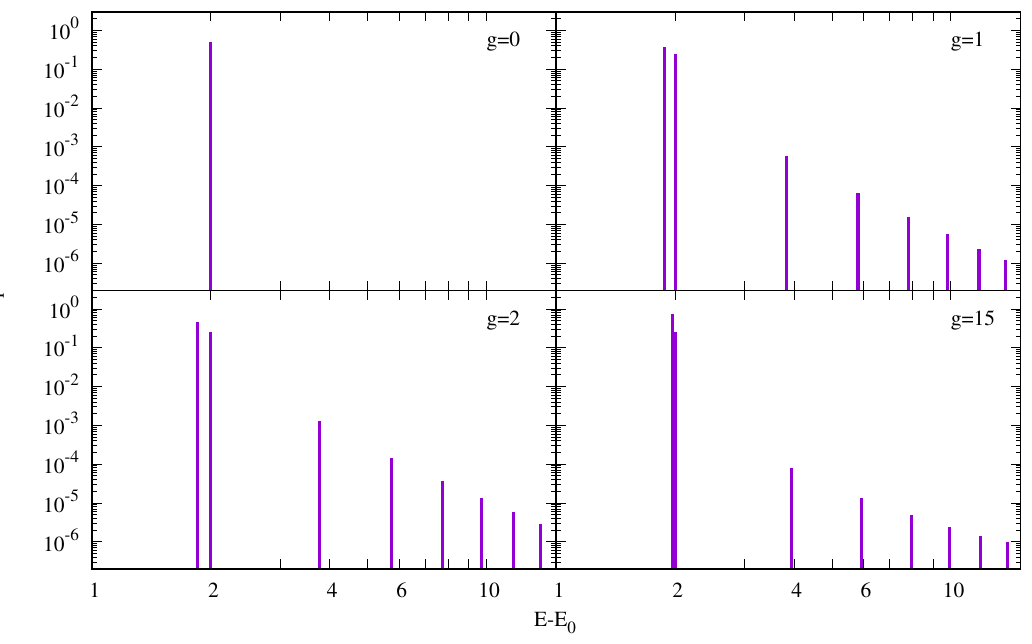
Figure 10. Dynamic structure function of a mono-polar excitation for the case of two fermions. The total spin of the ground state and of all excited states connected to it through the mono-polar excitation, are zero. The different panels correspond to four different values of interaction strength. From the non-interacting case, g = 0 to a strongly interacting one g =